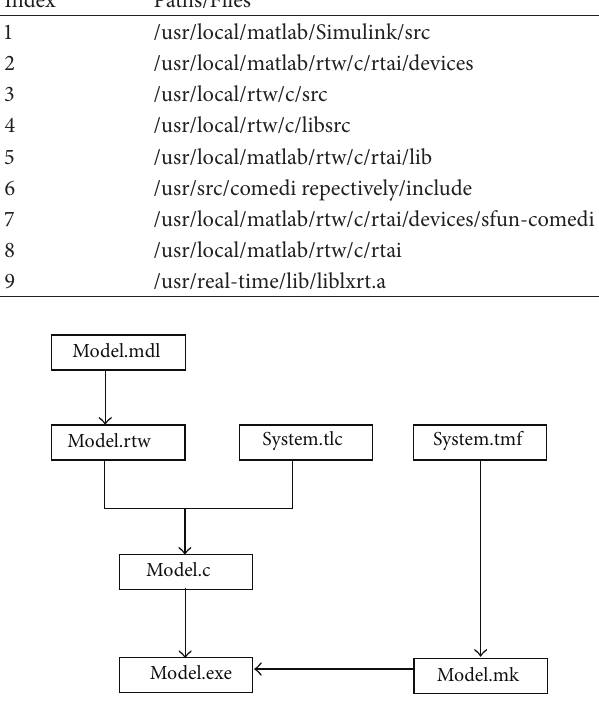
Figure 6: Automatic code generation